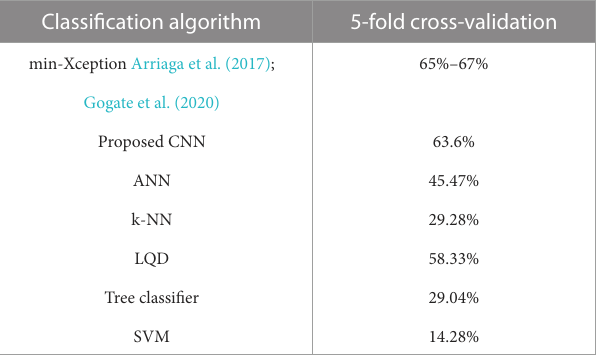
TABLE3 ComparisonoftheimplementedFERagainstotherclassifiers. Classification